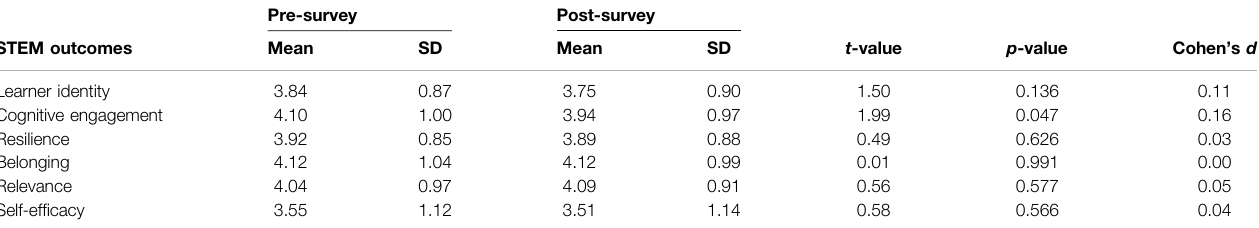
TABLE 2 | Comparison of pre- and post-survey outcome scores for six affective constructs related to STEM learner identity and motivational resilience ( n (cid:1) 172).